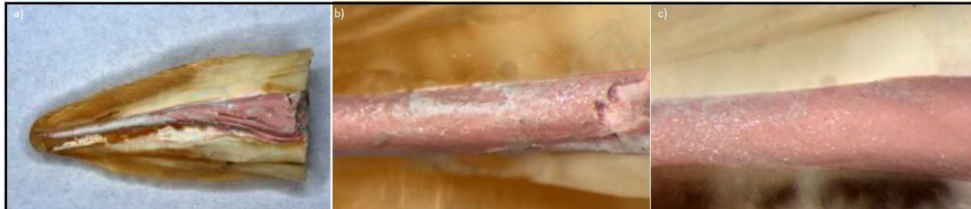
Figure 11. View of the fracture of the longitudinal root of the tooth filled with cold resilon (LSM); ( a ) general view; ( b , c ) the border between the root canal wall and the filling material in the apical area ( b ) with a visible leak passing into the truncated joint; ( c ) close adhesion of resilon to a thin intermediate layer of sealant.